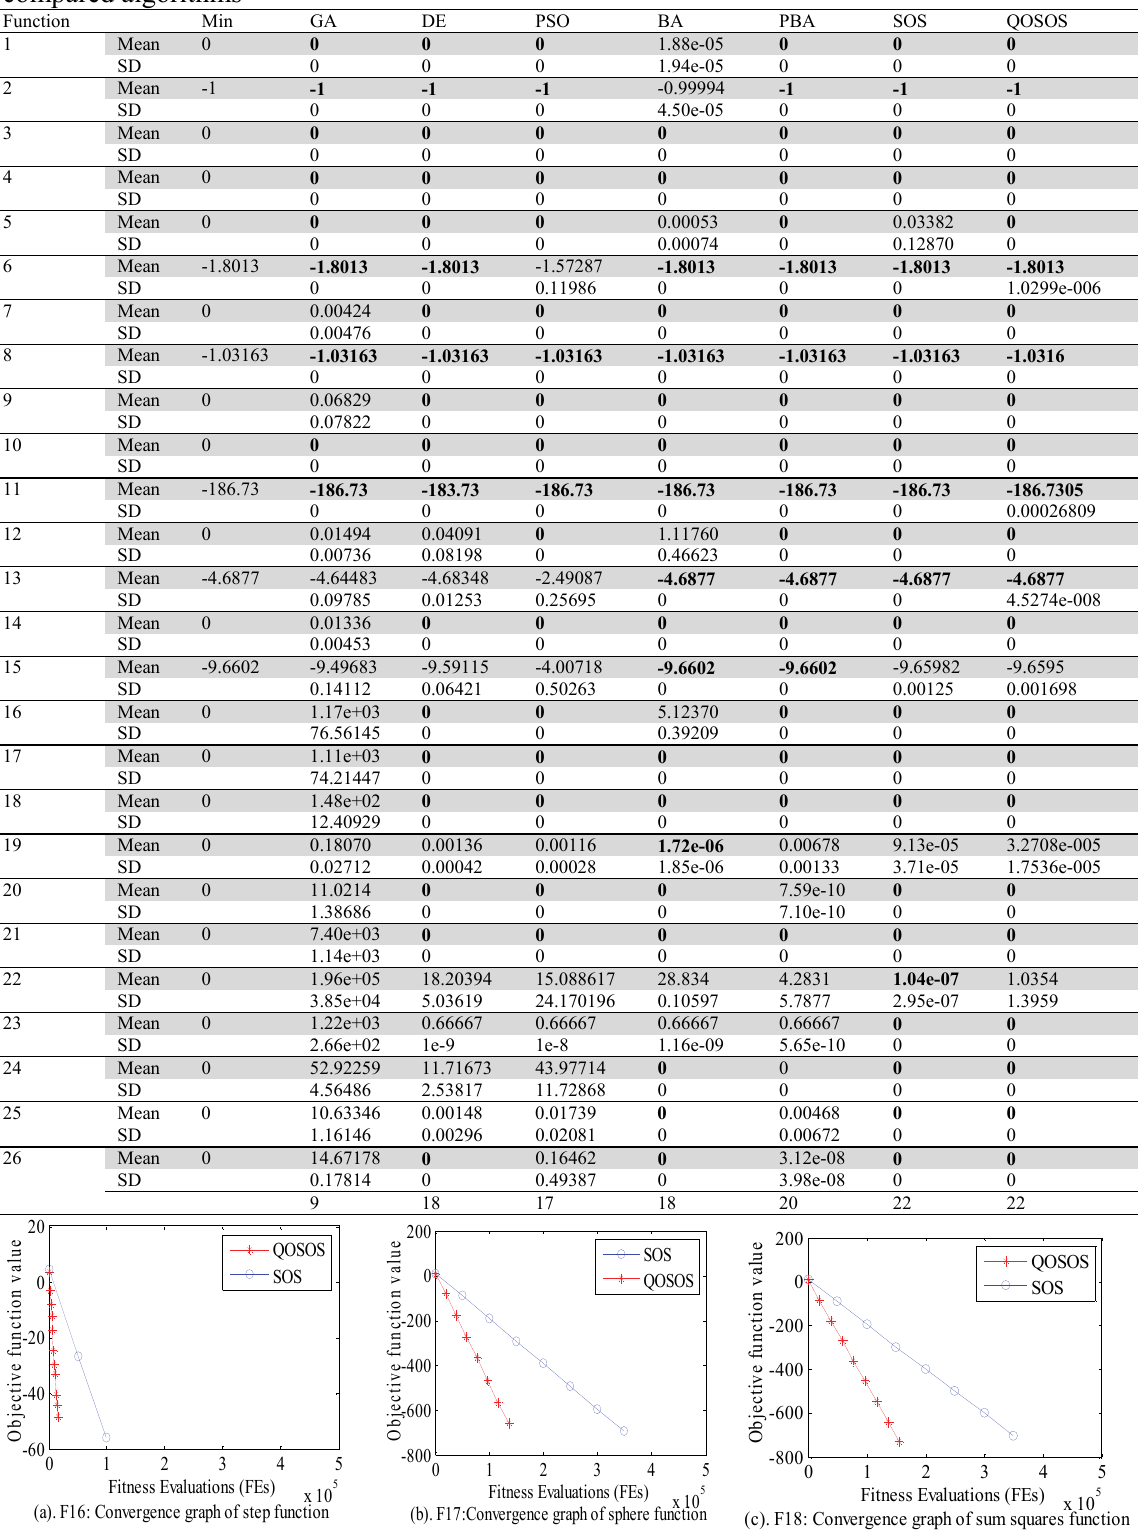
Performance results of GA , DE, PSO, BA, PBA, SOS and QOSOS after reaching 500000 FEs of twenty six well known test functions over 30 runs. ‘‘Mean ’’ and ‘‘SD’’ show the average and standard deviation of the test function respectively. Boldface represents the best result among the compared